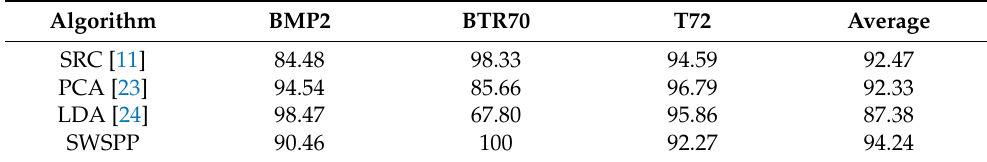
Table 3. Classification results (%) of different